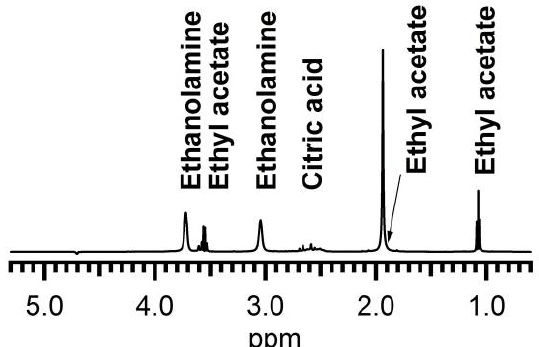
Figure 3. 1D proton NMR spectrum of solution A after microwave treatment, purification and the addition of CA and EA.